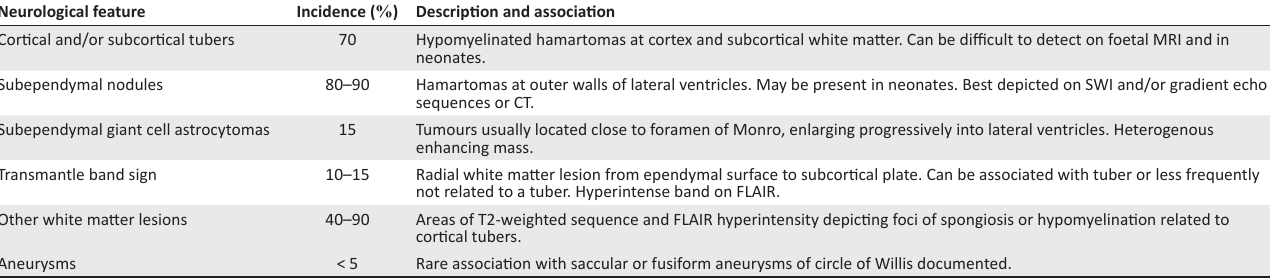
FIGURE 8: Schematic drawing depicting the location of the most common neuroimaging features of tuberous sclerosis. TABLE 2: Common neurologic features of tuberous sclerosis. Neurological feature Incidence ( % ) Description and association